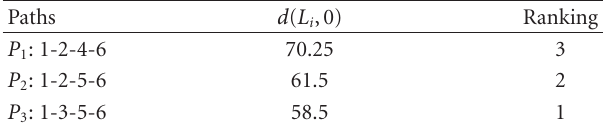
Table 2: Results of the network based on level λ -triangular LR weighted average index.